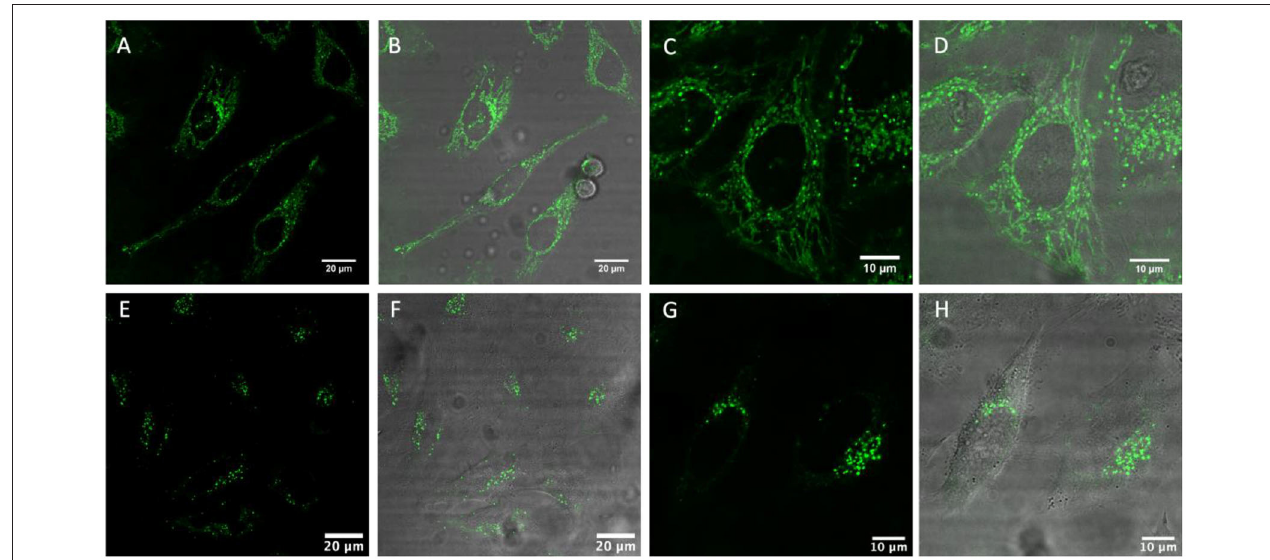
FIGURE 4 | Live HeLa cells stained with [Ru(dpp) 2 (16-ATAP)] 2 + (A–D) and [Ru(dpp) 2 (11-ATAP)] 2 + (E–H) at 2.5 µ M for 24h. (A,C,D,E) show the ruthenium emission channel, and (B,D,F,H) shows the overlay of the ruthenium channel with brightfield channel.